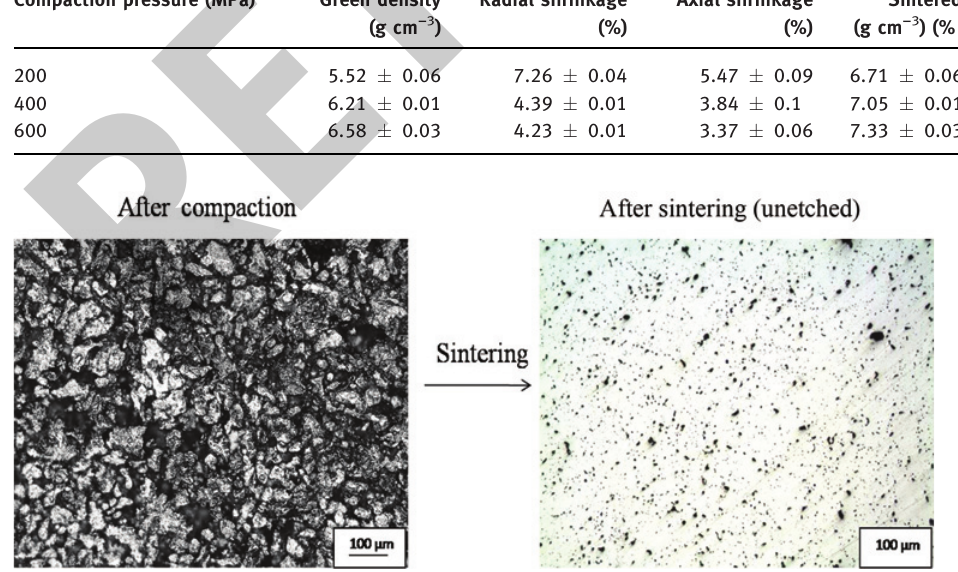
Table 2: Effect of compaction pressure on densification response of 316L stainless steel sintered at 1,400°C. Compaction pressure (MPa) Green density